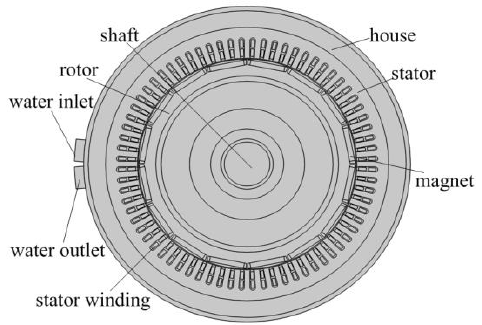
Figure 1. The structure of the in-wheel motor (IWM).